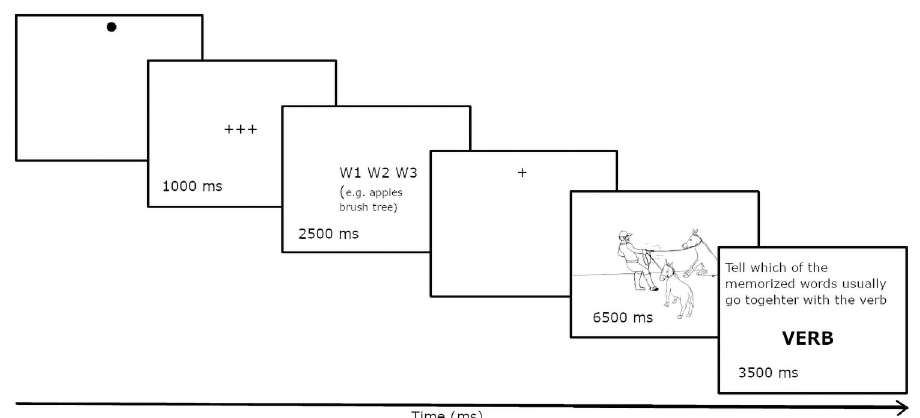
Fig 4. Presentation sequence of stimuli in trials with the concurrent memorization